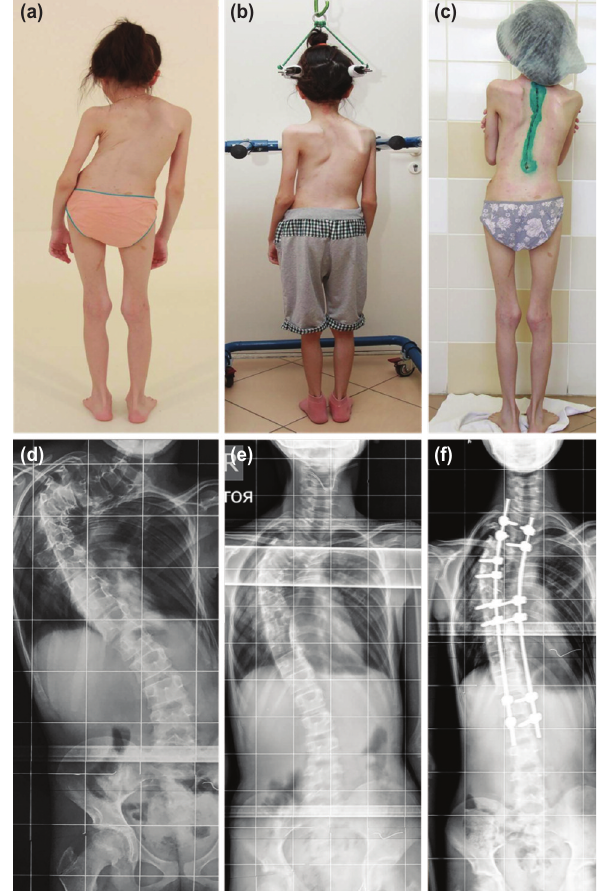
13-year old with Neurofibromatosis (Case 3). Images Fig. 3: (a) pre-operative, (b) on traction and (c) post-operative. Radiographs (d) Pre-operative, (e) on traction and (f)